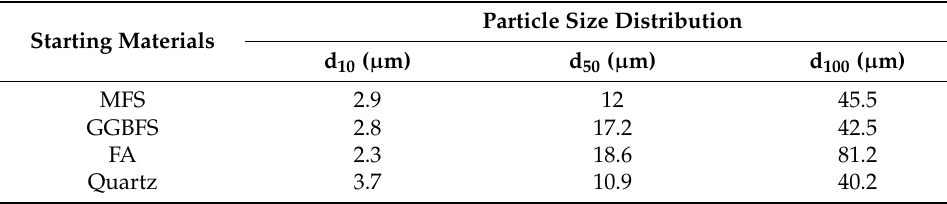
Table 5. Particle size distribution of the starting